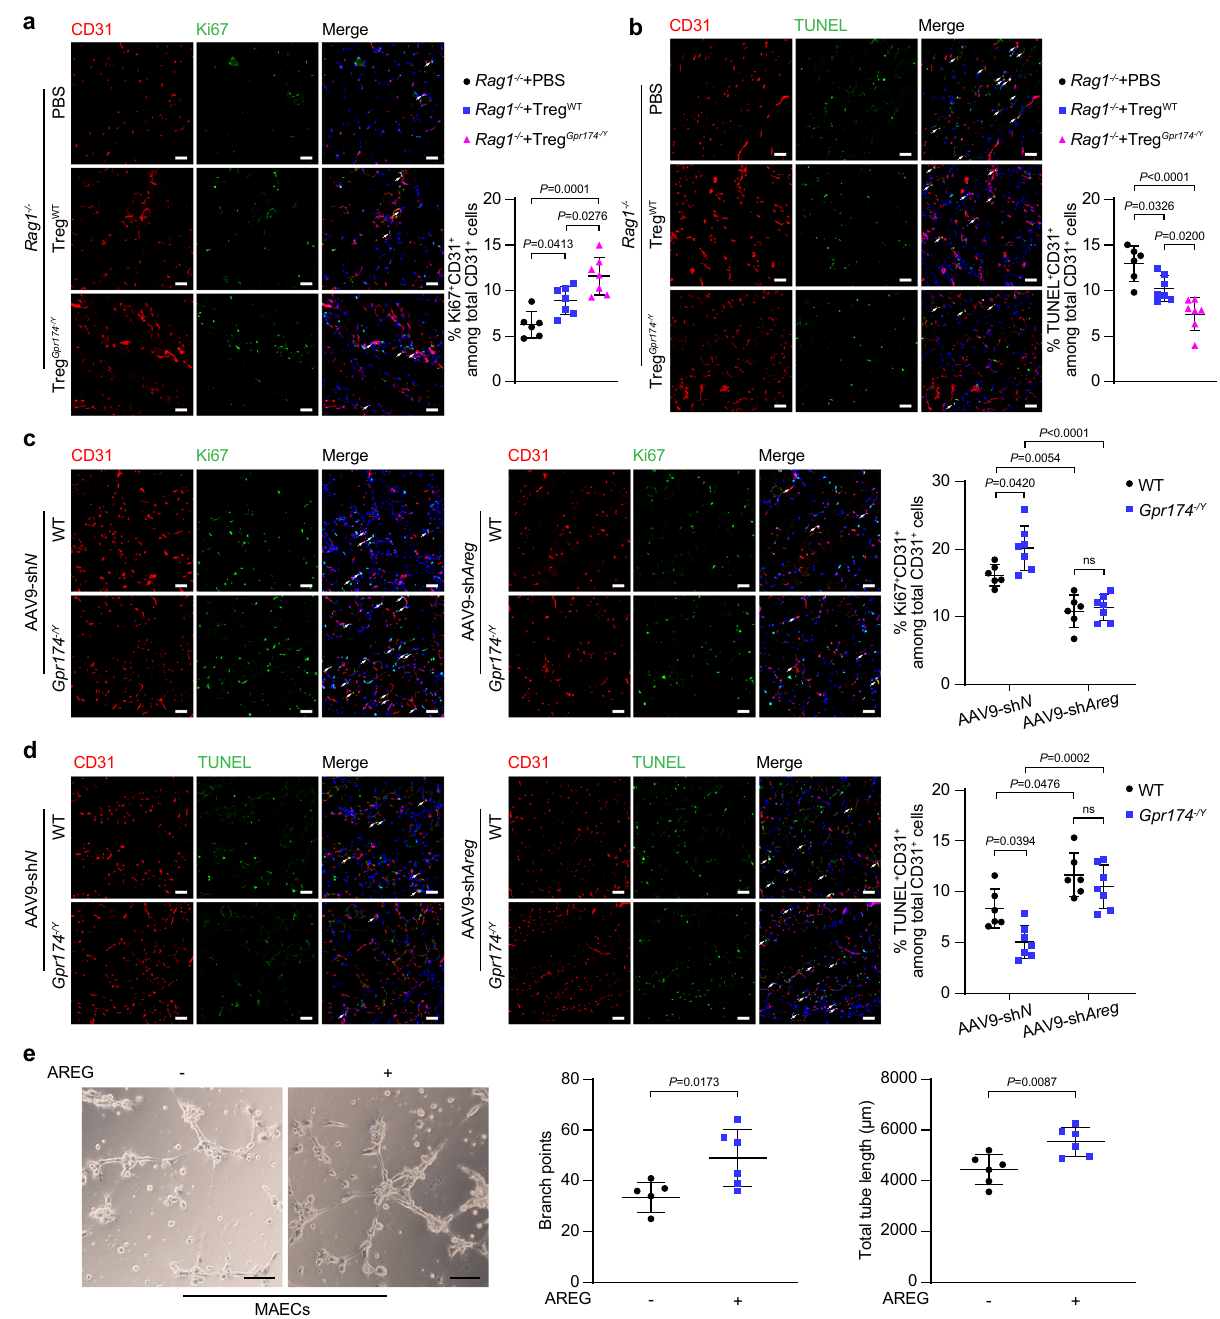
Fig. 4 | AREG mitigates apoptosis and enhances tube formation in endothelial cells. a Representative immuno fl uorescent image of CD31 (red), Ki67 (green) and DAPI(blue)andquanti fi cationofCD31 + Ki67 + cellsinmusclecrosssectionsof Rag1 − / − mice receiving Tregs 7 days after adoptive transplantation experiments ( n =6 for PBS → Rag1 − / − mice; n =7forwild-typeTregs → Rag1 − / − mice; n =7forGPR174-de fi cient Tregs → Rag1 − / − mice).Scalebar,50 μ m. b Representativeimmuno fl uorescentimages of CD31 (red), TUNEL (green), and DAPI (blue) staining and quanti fi cation of CD31 + TUNEL + cells in muscle cross sections of Rag1 − / − mice receiving Tregs 7 days after adoptive transplantation experiments ( n =6 for PBS → Rag1 − / − mice; n =7 for wild-type Tregs → Rag1 − / − mice; n =7 for GPR174-de fi cient Tregs → Rag1 − / − mice).Scale bar,50 μ m. c Representativeimmuno fl uorescentimagesofCD31(red),Ki67(green) and DAPI (blue) and quanti fi cation of CD31 + Ki67 + cells in muscle cross sections of WT and Gpr174 − /Y mice injection with AAV9-sh Areg 14 days after HLI ( n =6 for